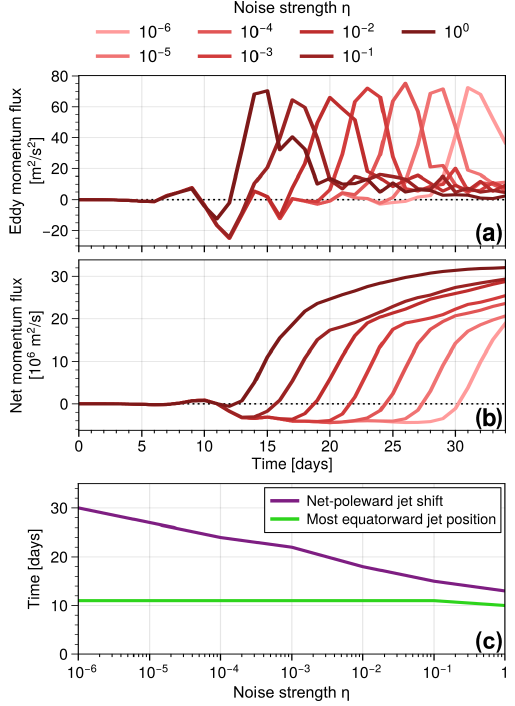
Figure 5. Evolution of (a) hemispherically averaged eddy momen- tum flux and (b) accumulated net eddy momentum flux for LC2 initial conditions and different values of noise strength η . (c) Time of the most-equatorward-shifted jet (maximum of the zonal mean zonal wind profile at 10km), as well as the time when the corre- sponding wind maximum, is located north of the initial wind maxi- mum (45 ◦ ) for the first time during the experiment. All lines show the mean over three realisations of initial